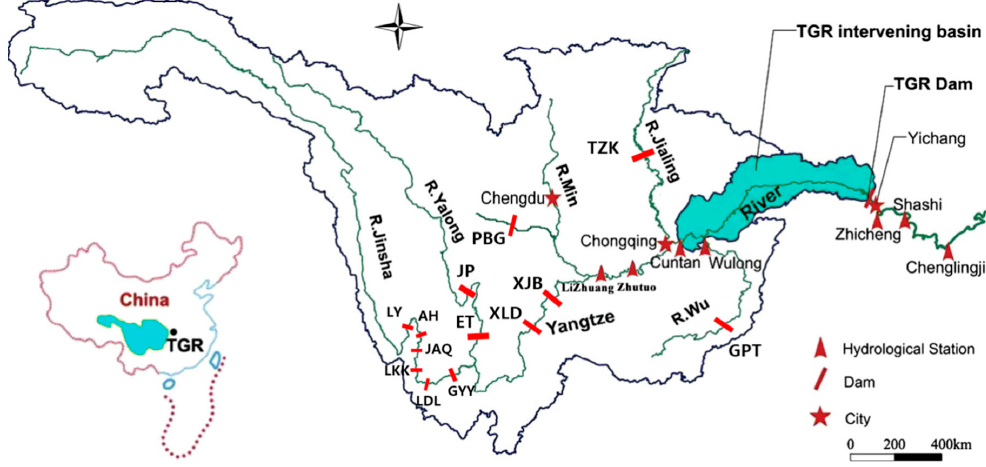
Table 1. The selected rivers and